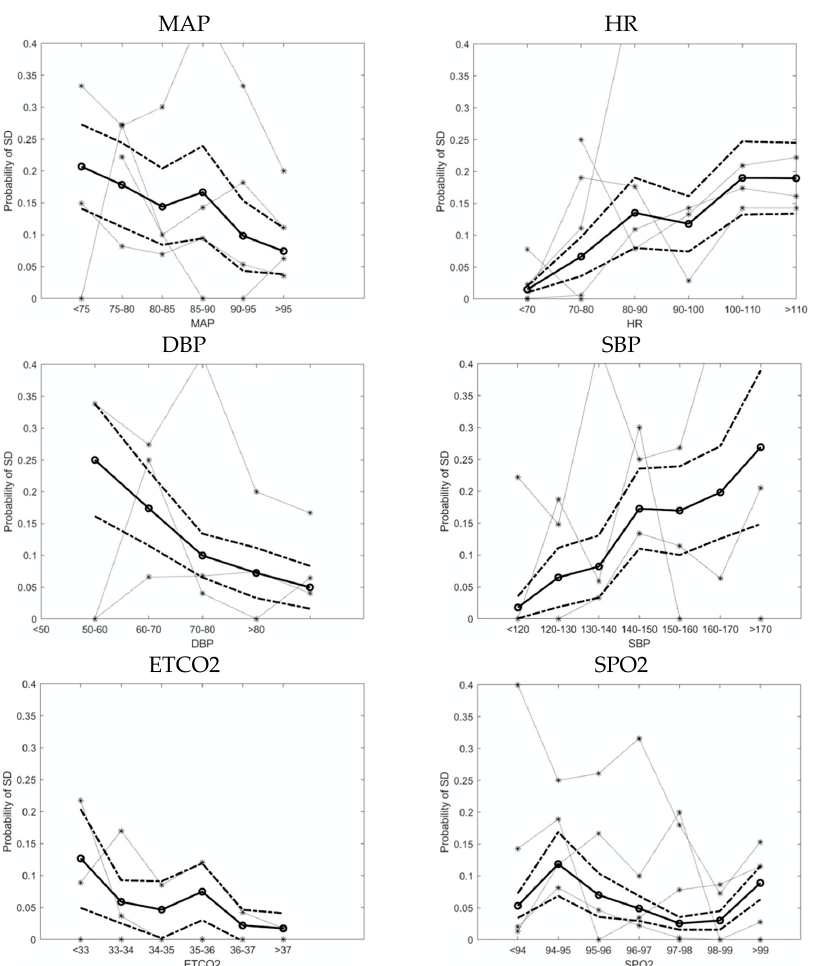
Figure 1. Probability of SD as a function of 20-minute time-binned continuous variables, with probability curves of individual patients shown separately. The bold lines represent the mean and 95% CI probability curves for all patients. Lower MAP was associated with increased probability of SD and the effect appears to be driven by lower DBP. Lower ETCO2 and higher HR was also associated with increased probability of SD. MAP = mean arterial pressure, HR = heart rate, DBP = diastolic blood pressure, SBP = systolic blood pressure, ETCO2 = end tidal CO2, SPO2 = peripheral oxygen saturation.